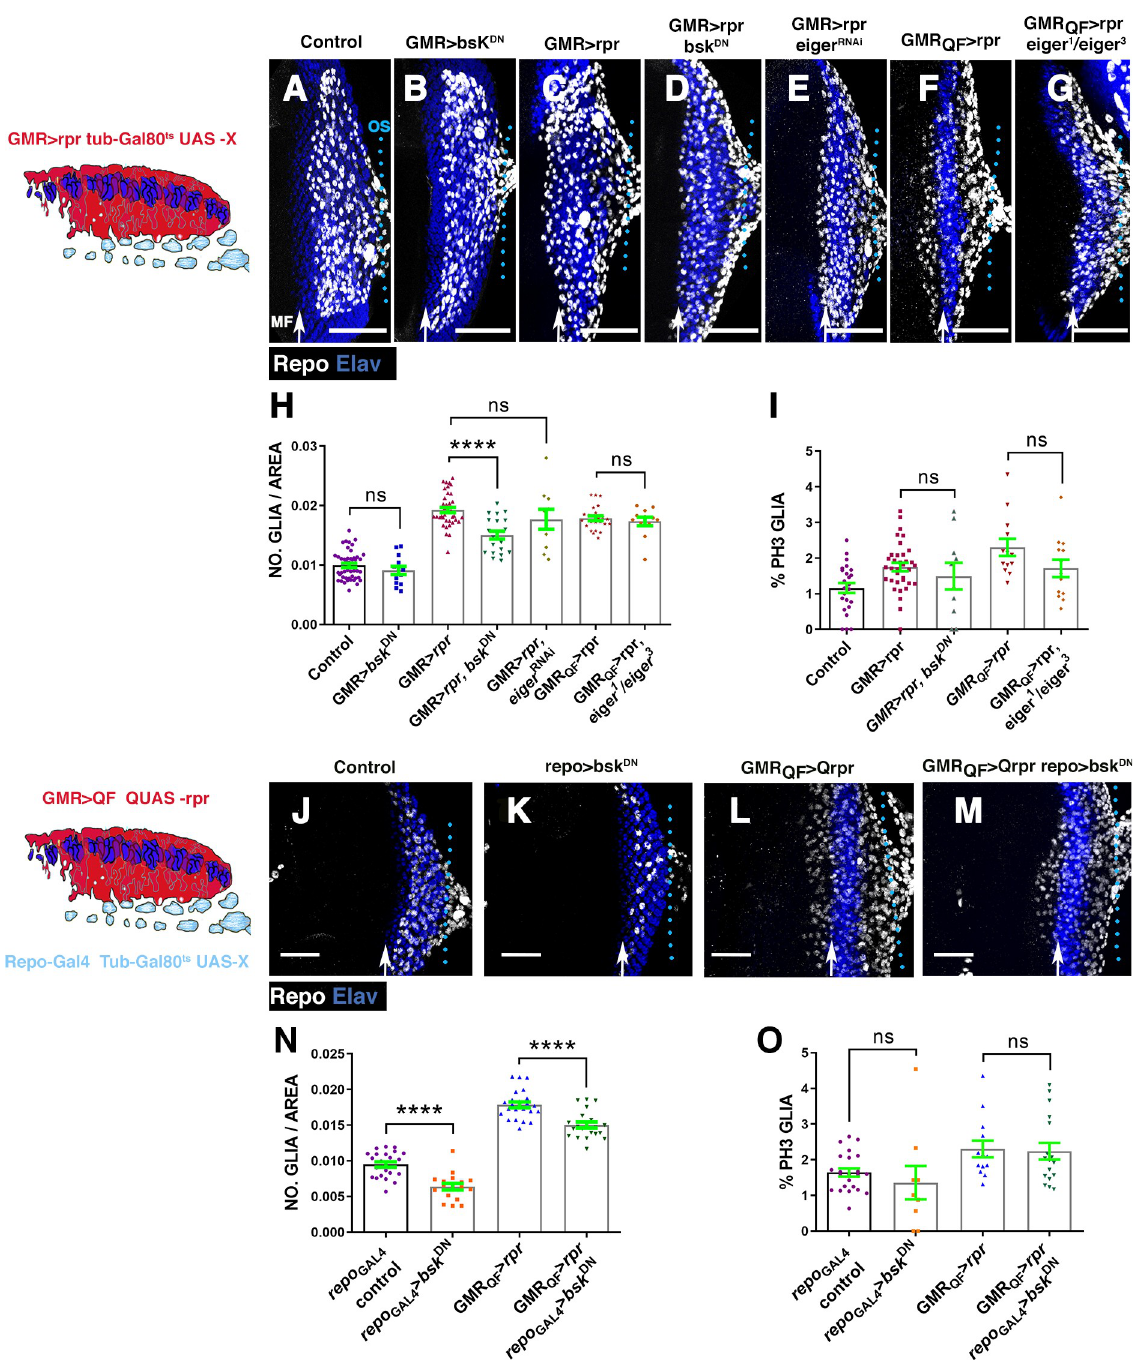
Fig 6. Reduction of JNK activity prevents the accumulation of glial cells produced upon cell death induction. (A–G and J–M) Projections of confocal images of third instar eye discs stained with anti-Elav (blue) and anti-Repo (white). The schematic illustration on the left represents a transverse section of an eye disc where the region marked in red (expression domain of GMR-Gal4) corresponds to the area of the discs that has been damaged at the same time that JNK was depleted. (A) Control undamaged GMR-Gal4 tub-Gal80 ts /+ disc. (B) UAS-bsk DN ; GMR-Gal4 tub-Gal80 ts /+ eye. (C) Damaged UAS-rpr/+; GMR-Gal4 tub-Gal80 ts /+ discs. (D) UAS-rpr/UAS-bsk DN ; GMR-Gal4 tub-Gal80 ts /+ damaged discs. (E) UAS-rpr/; GMR-Gal4 tub-Gal80 ts /UAS-eiger RNAi . (F) GMR-QF; QUAS-rpr eye discs damaged. (G) Damaged GMR-QF; eiger 1 /eiger 3 ; QUAS-rpr . All larvae were subjected to the same temperature shifts (see Materials and methods) except larvae of the discs shown in F and G that were raised at 25˚C throughout the development. (H–I) Graphs show glial cell density (H) and percentage of mitotic glia cells of discs shown in A–G. (J–M) Effects of the down-regulation of JNK in glial cells of damaging eye discs. In the schematic illustration on the left is